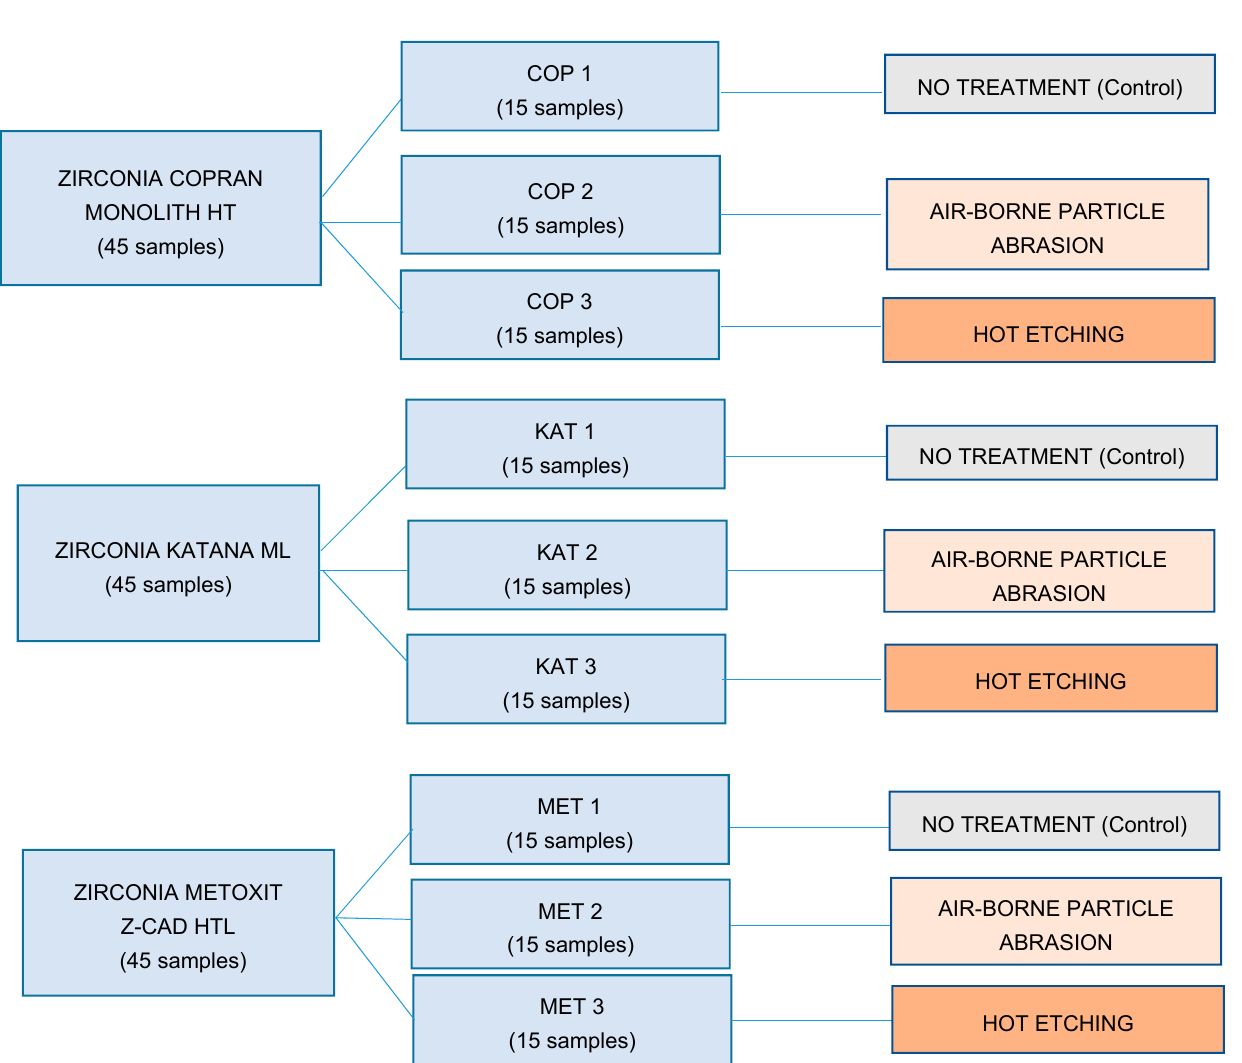
Figure 1. Flow chart showing how the tested materials were divided into groups and the respective treatment